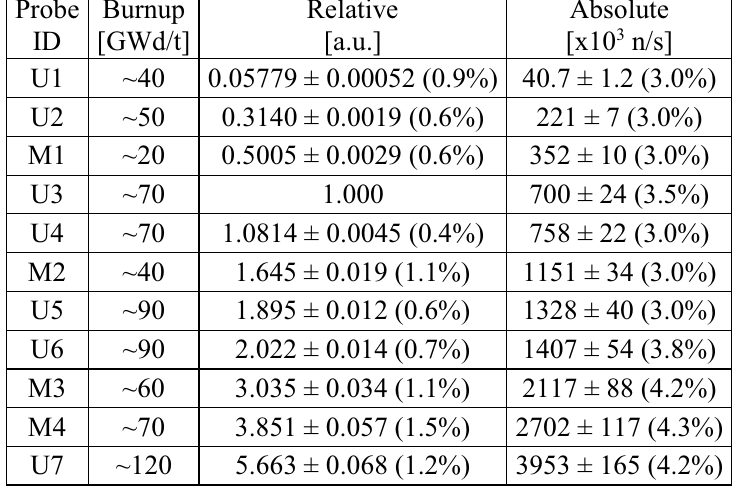
Table II.: Measured relative and absolute neutron emission rates with their (cid:2)(cid:3)(cid:4)uncertainties